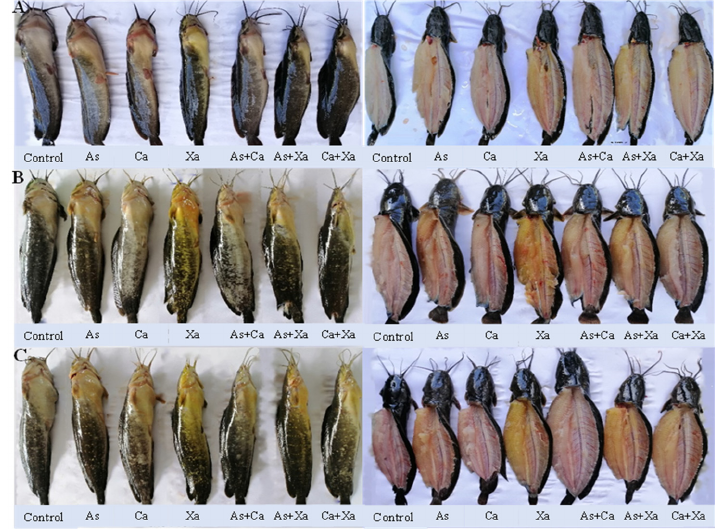
Figure 3. Digital image of body skin and muscle of bighead catfish fed dietary carotenoid pigments for 2 weeks ( A ), 4 weeks ( B ), and 6 weeks ( C ).